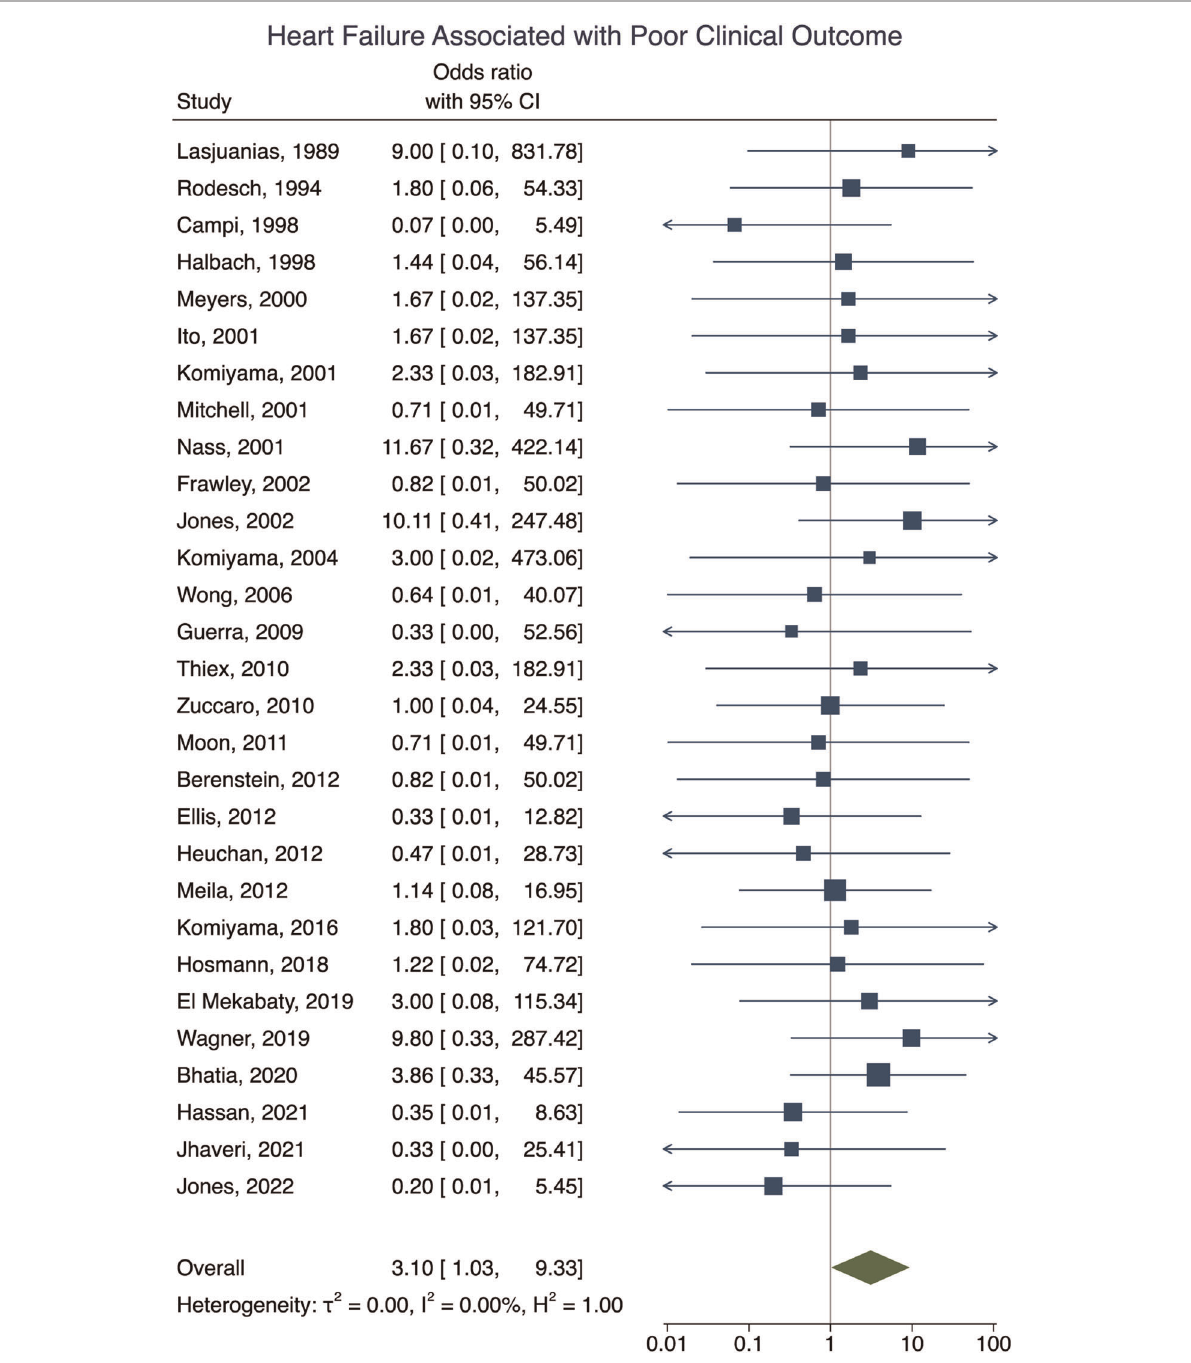
between sex, angioarchitecture of the lesion, single or multistage embolization, or embolization vascular access route and poor clinical outcome was found. Factors associated with mortality following VOGM embolization.